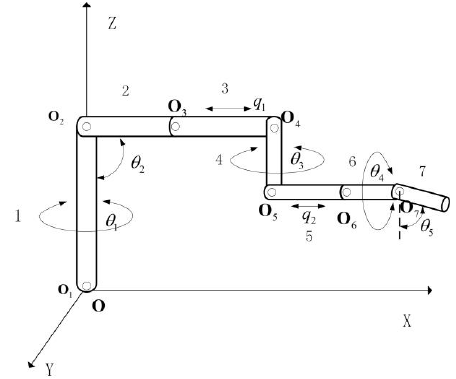
Figure 4. The 7-DOF manipulator coordinate diagram.